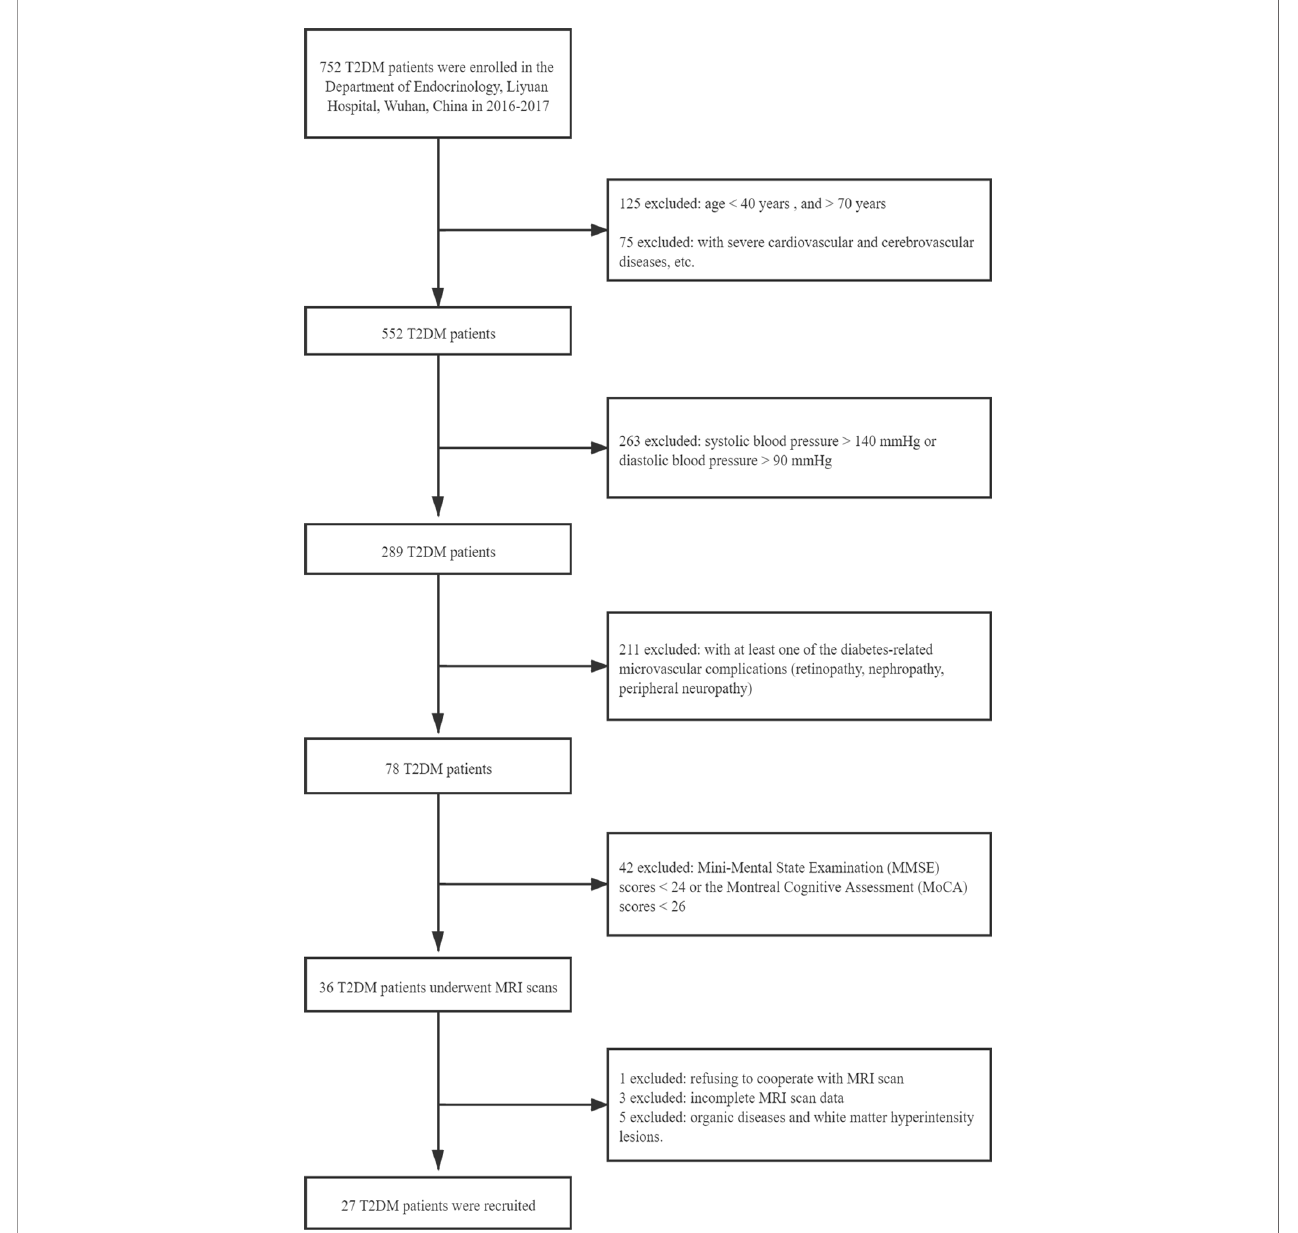
FIGURE 1 | Flowchart of the exclusion and inclusion criteria for type 2 diabetes mellitus (T2DM) patients without clinical evidence of cognitive impairment and microvascular